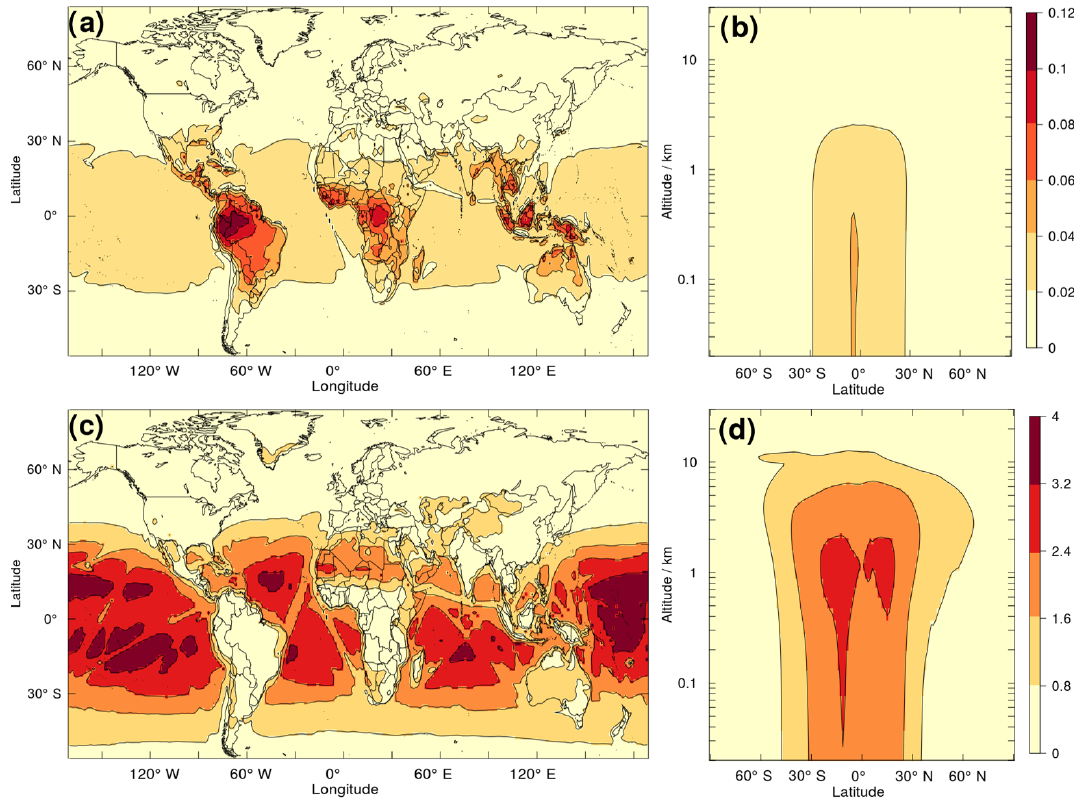
Figure 10. Changes in total k OH from the inclusion of RO 2 + OH reactions: (a) global surface change in s − 1 and (b) zonal mean in s − 1 ; (c) percentage change at the surface and (d) percentage change zonal